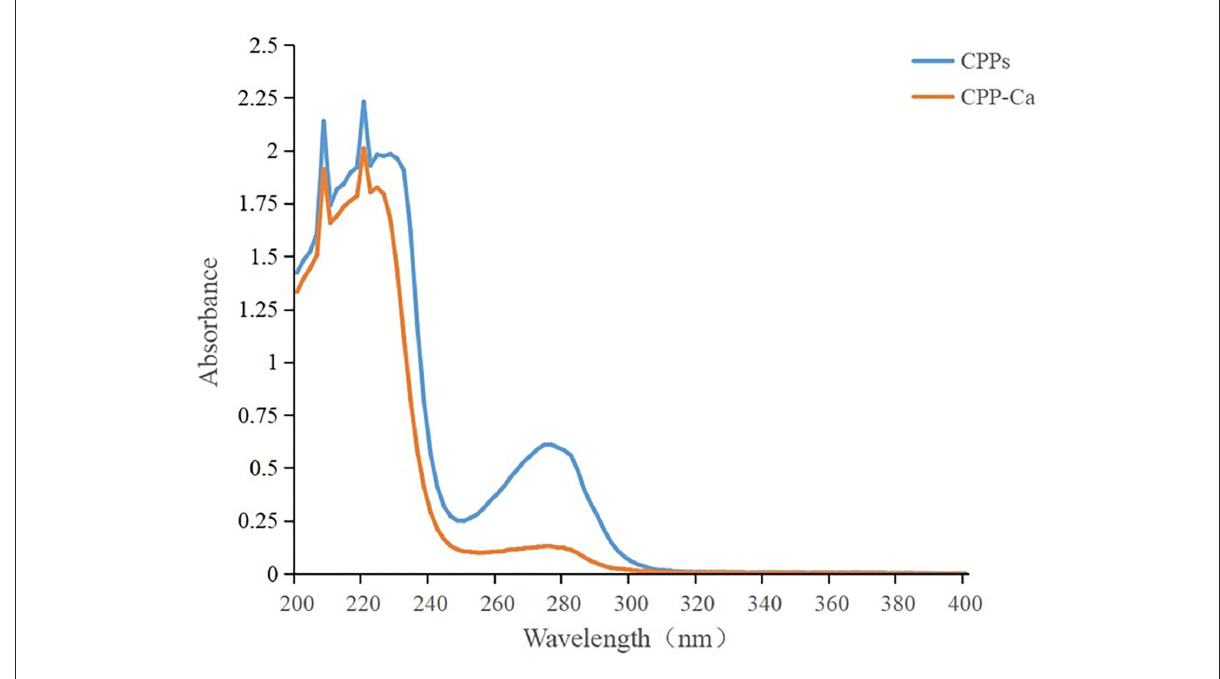
FIGURE2 UV–Vis spectra of CPPs and CPP-Ca.